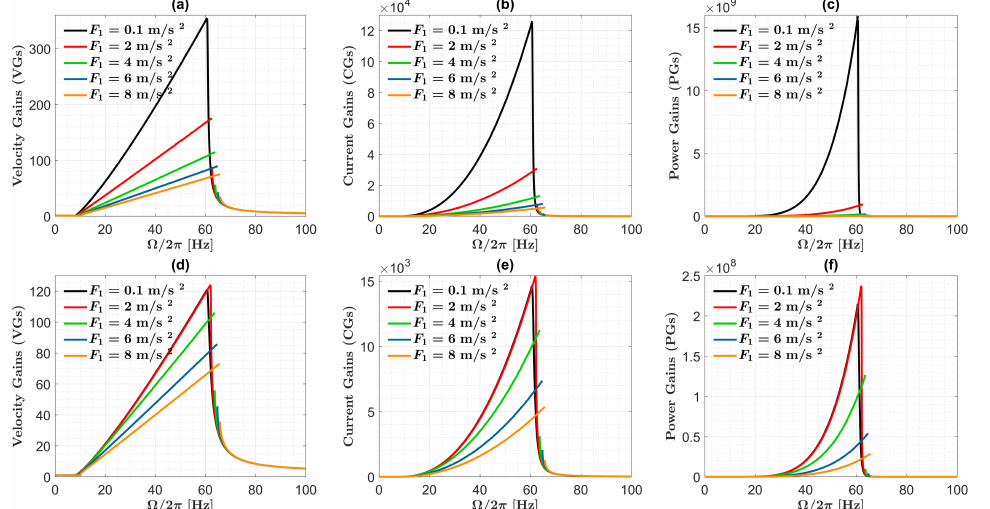
Figure 8. Performance gains achieved by the self-adaptive harvester for five excitation amplitudes: ( a – c ) VG , CG and PG for R l = 1 M Ω ; ( d – f ) VG , CG and PG for R l = 188 Ω